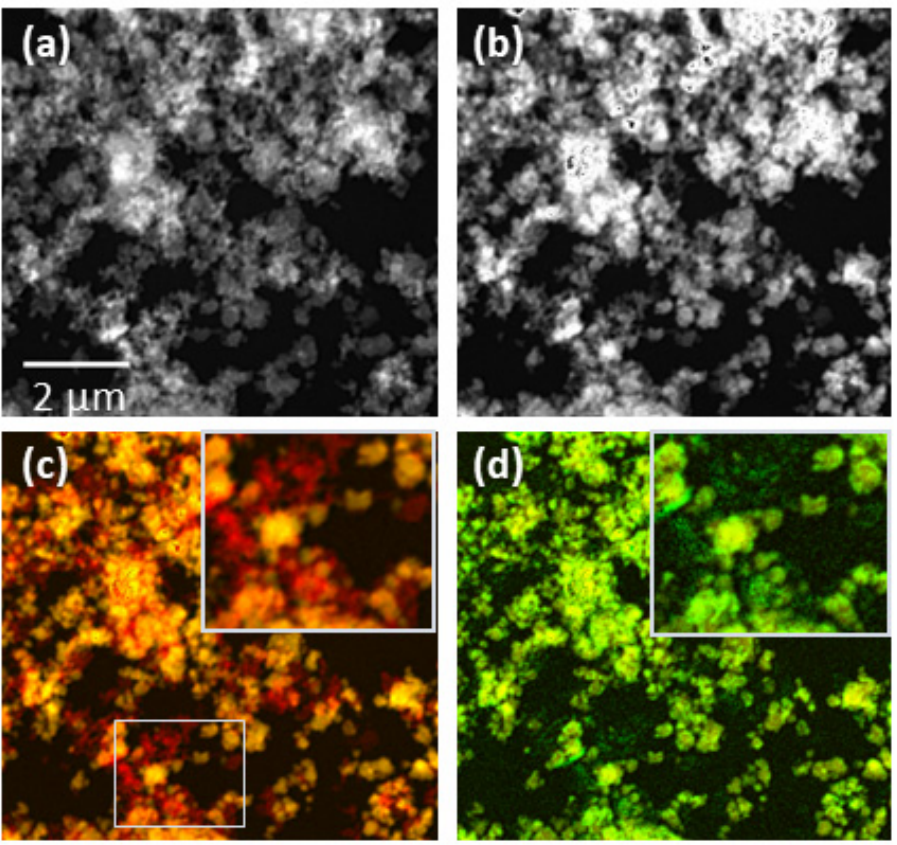
Figure 3. Images obtained from the pristine Vanadium-coated sample. ( a ) absorbance map averaged in the O-K pre-edge energy range (526.3–527.2 eV); ( b ) absorbance map averaged in the O-K prepeak energy range (C peak region, 530.3–530.1 eV); ( c ) composite image with following channels: red ( a ), and yellow (difference b - a ); ( d ) composite image from the V-L region (516.8–525.9 eV), green channel, and ( b ), yellow channel. The background from the pre-edge has been subtracted from both oxide and vanadium components. Insets in ( c , d ) show a detail at increased magnification.